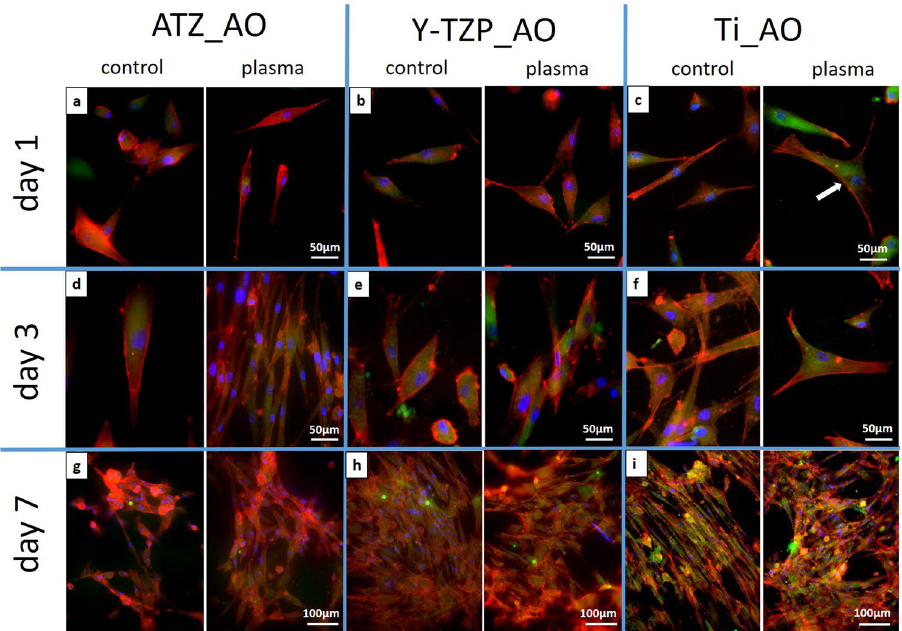
Figure 7. Indirect immunofluorescence of the phalloidin-labelled actin (red fluorescence) and the focal adhesion protein vinculin (green fluorescence) in osteoblasts cultivated for 1, 3 or 7 days on plasma- functionalized and control surfaces. Nuclei were counter-stained with Hoechst 33342 (blue fluorescence). Arrows point to actin stress